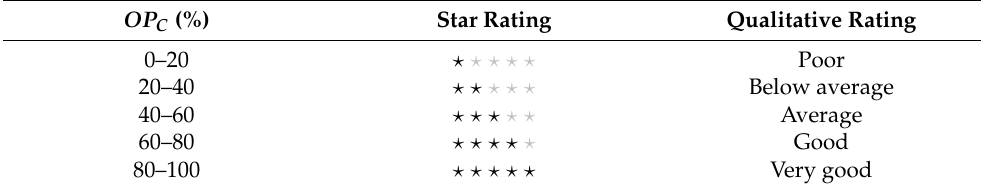
Table 2. AWI 22834 rating